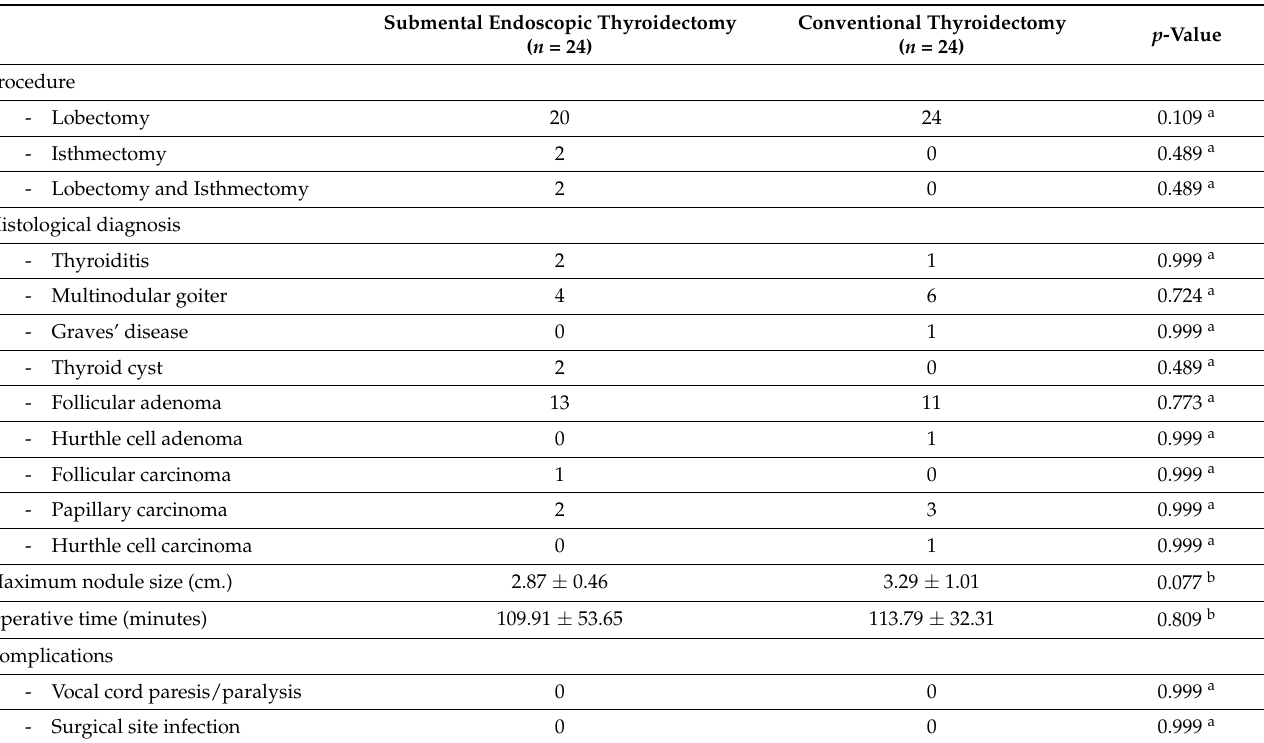
Table 2. Operative details.